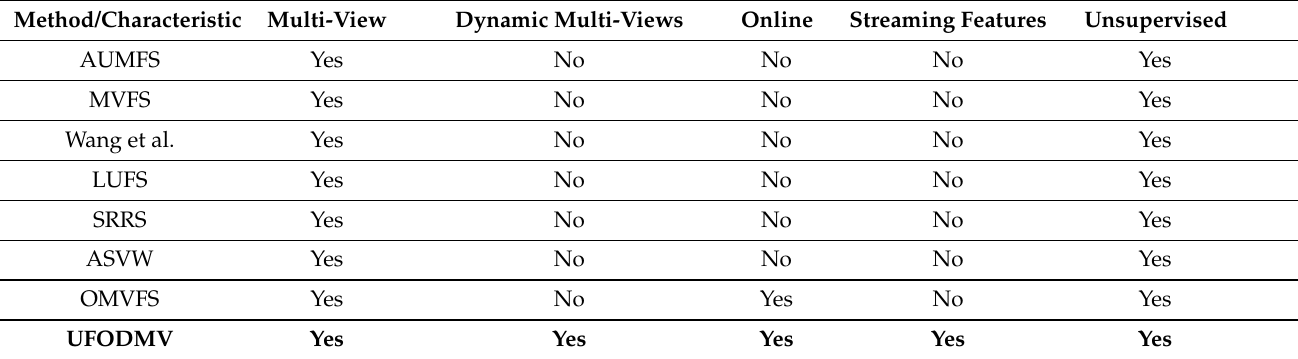
Table 1. Characteristics of existing multi-view feature selection